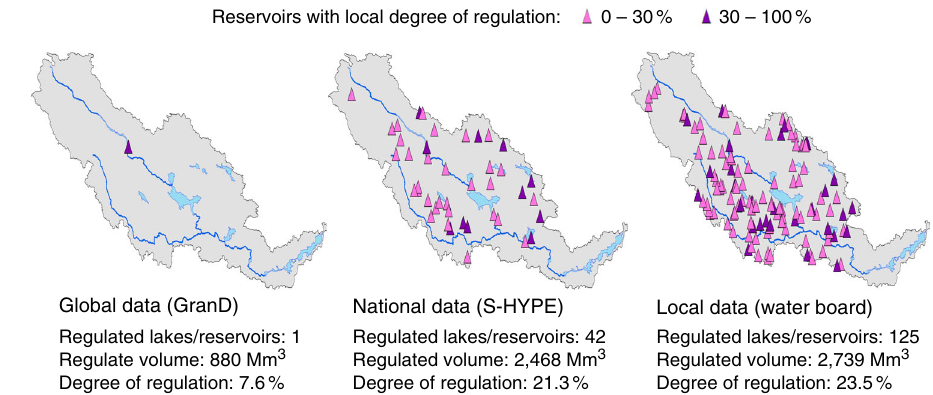
Fig. 4 Information of hydropower regulation in Dalälven River using different